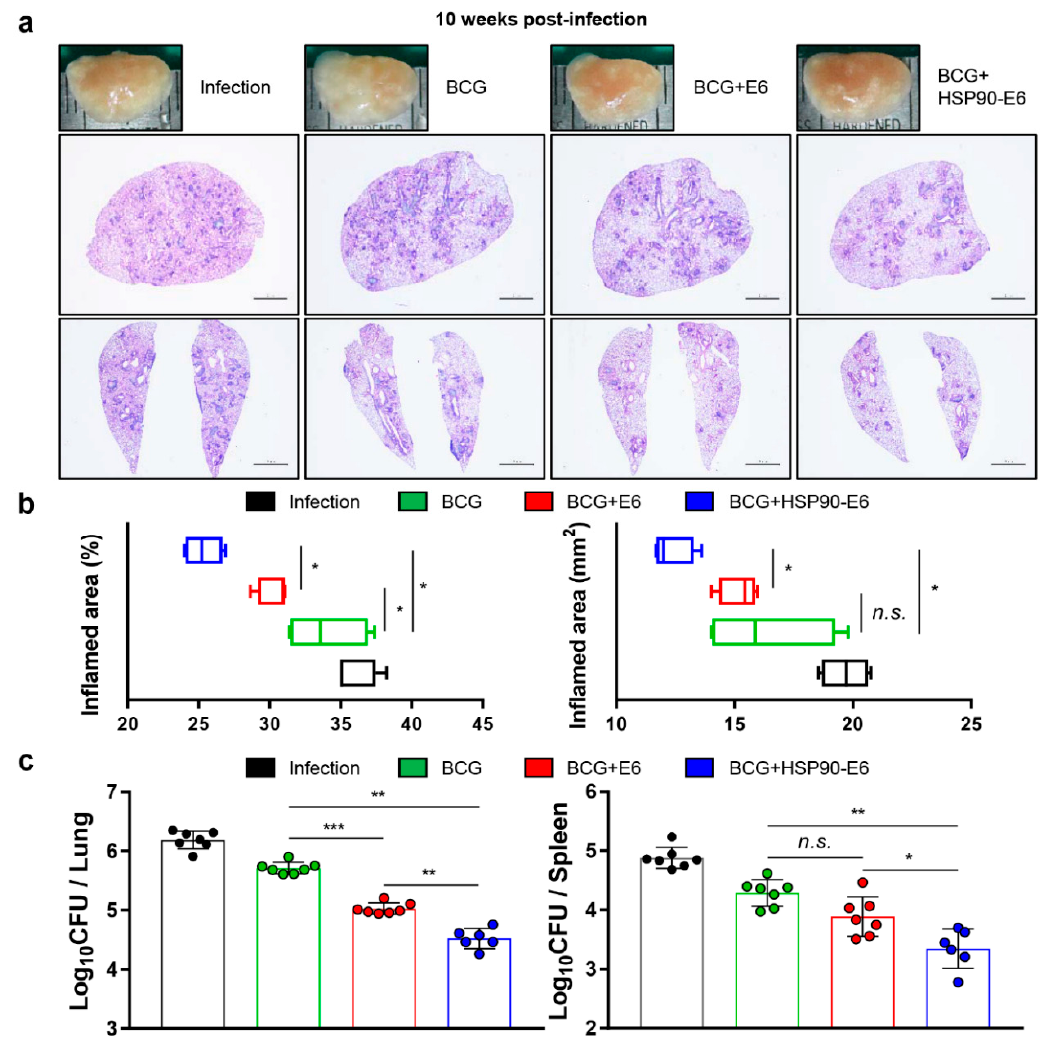
Figure 3. HSP90-E6 / CIA05 booster vaccination improves BCG-primed protection against hypervirulent Mtb HN878. ( a ) H&E staining of superior lobes of the right lung of each immunised mouse at 10 weeks after Mtb HN878 infection (scale bars = 2.0 mm). ( b ) Inflamed area as % of the total area (left) and lesion size (right) in the lungs. ( c ) Colony forming units (CFUs) in the lungs and spleen in all treatment groups at 10 weeks post-infection, determined by counting the viable bacteria. Data are from one of two independent experiments ( n = 6 or 7 mice per group at each time point). Mann-Whitney rank tests were used to compare groups. n.s. : not significant, * p < 0.05, ** p < 0.01, and *** p < 0.001.